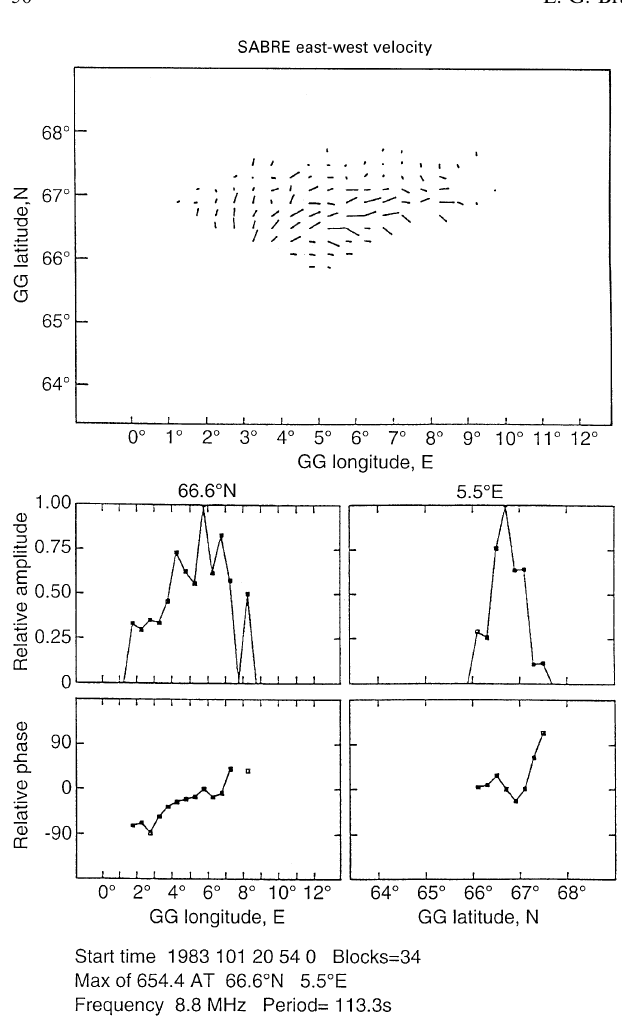
Fig. 7. Amplitude and phase characteristics throughout the SABRE field of view ( top ) determined from FFT spectral analysis of the SABRE east-west velocity component data on day 101, 1983. The amplitude ( middle ) and phase ( bottom ) as a function of latitude are very complicated around the amplitude peak while the longitudinal phase difference of (cid:92) 50 ° in (cid:92) 3 ° of longitude implies an m value of (cid:92) 17 and a westward propagating